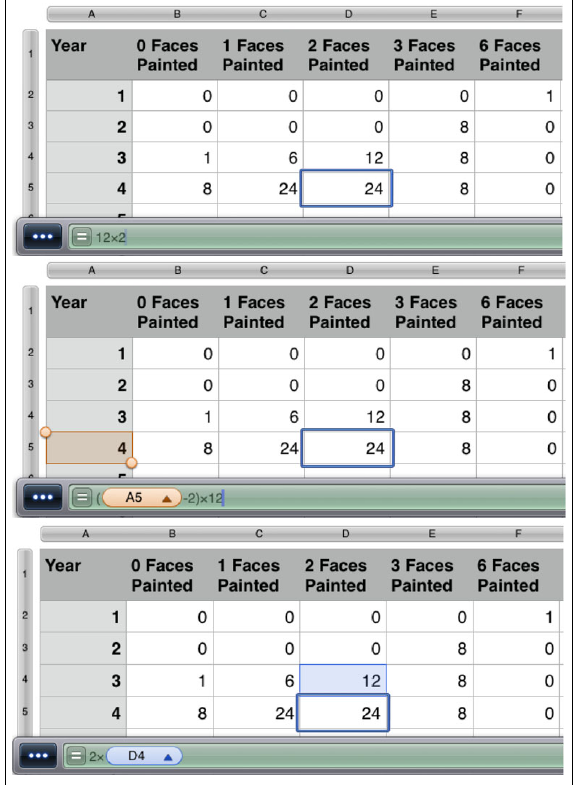
Figure 1. Different uses of the spreadsheet: a) in the top, arithmetic operations, b) in the middle, a recursive formula, and c) in the bottom, a general